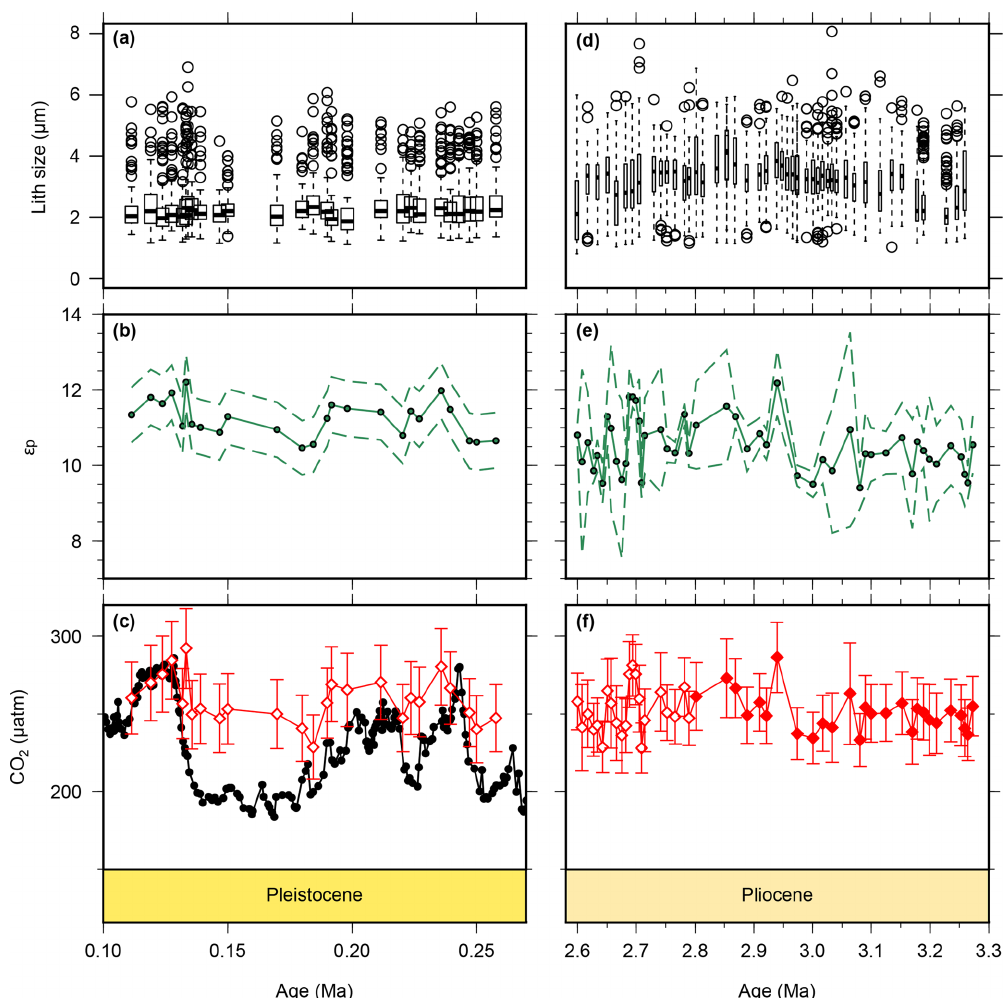
Figure 4. Lith size data for samples used for CO 2 calculations. Pleistocene lith size (a) are from this study, whilst Pliocene (b) values were published previously (Davis et al., 2013) but are from the same samples as our CO 2 estimates. Pleistocene ε p (b) are from this study, whilst the Pliocene data are from this study (2.6–2.8Ma) and from Badger et al. (2013b) (2.8–3.3Ma). The lower panels show CO 2( ε Pleistocene (c) and Pliocene (f) as red diamonds. The filled diamonds in panel (f) are from Badger et al. (2013b). The Pleistocene ice core data (Bereiter et al., 2015 and Table 1) are shown for comparison in panel (c) . The drop in lith size from the Pliocene to Pleistocene is similar to what has been documented previously (Young, 1990). Outliers in panels (a) and (d) were calculated following the 1.5 rule in R (R Core Team,